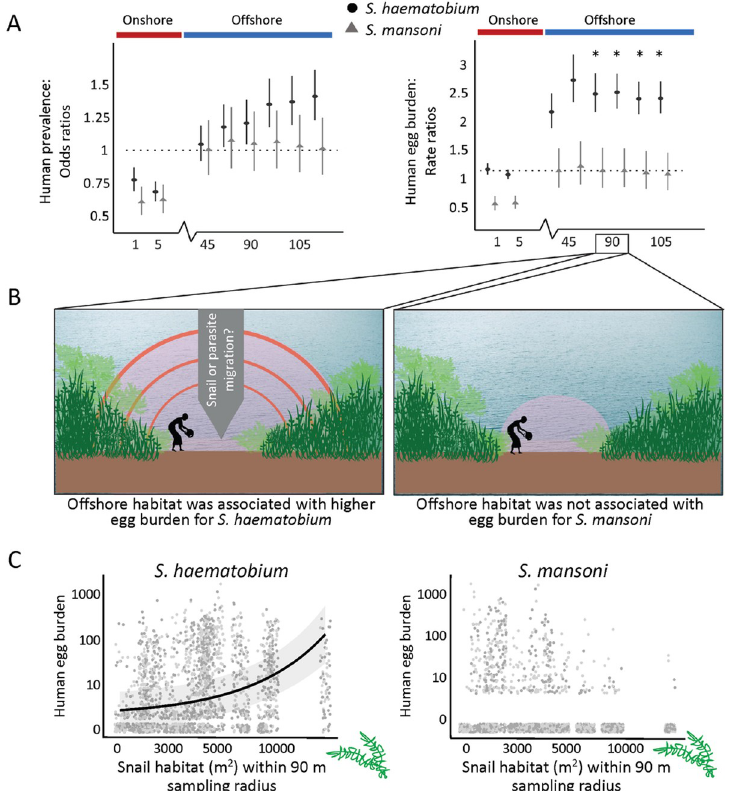
area of non-emergent vegetation measured within different sampling radii; each point estimate and 95% confidence interval were derived from an independent model considering non-emergent vegetation measured at the specified sampling radius (x-axis). Asterisks indicate sampling radii at which a statistical difference ( � p < 0.05) between the two species was detected, as determined by an additional model that included an interaction term for species X non- emergent vegetation, independently for each sampling radius. (B) Visual interpretation of results: non-emergent vegetation within a sampling radius of 45 to 90 m was positively associated with S . haematobium egg burden as compared to S . mansoni , which was not positively associated with non-emergent vegetation at any sampling radius. (C) Predicted relationship between non-emergent vegetation and S . haematobium egg burden at a 90 m vegetation sampling radius (95% CI shaded in grey) (left); S . mansoni (right) was not associated with non-emergent